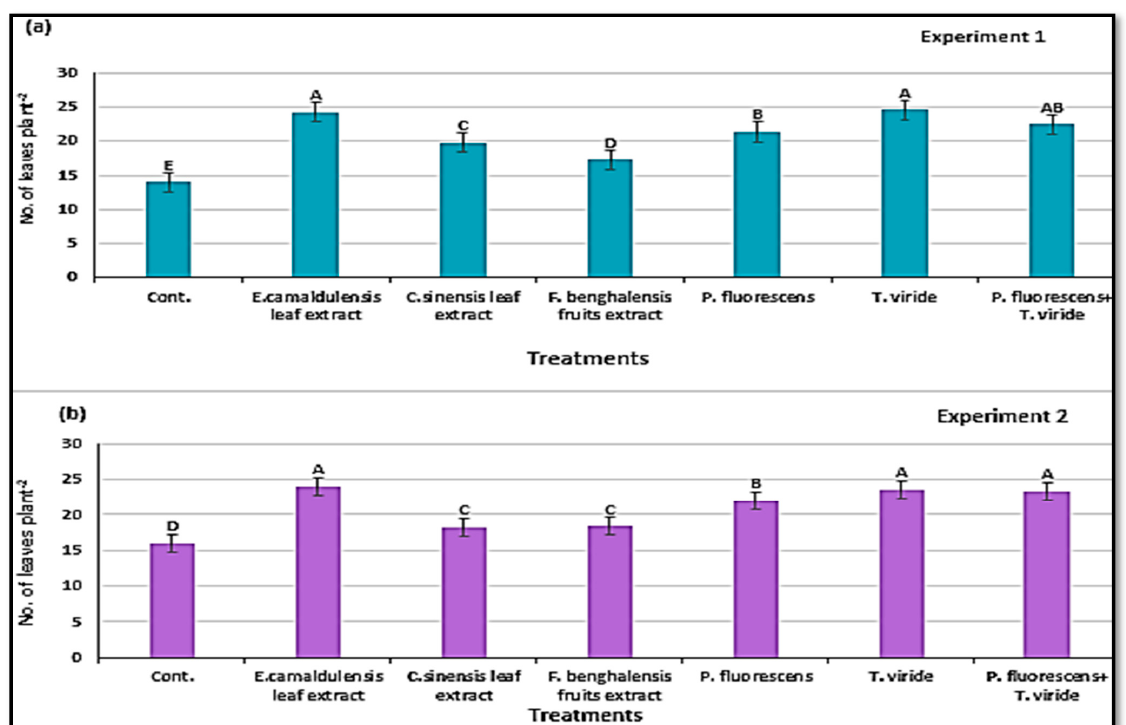
Figure 6. Number of leaves per plant (means ± S.E) of zucchini as affected by the natural plant extracts and microbial antagonists. Letters in figure indicate the means ± S.E of treatments with the same letter/s were not significantly different according to LSD at 0.05 level of probability. ( a ) Experiment 1; ( b ) experiment 2.